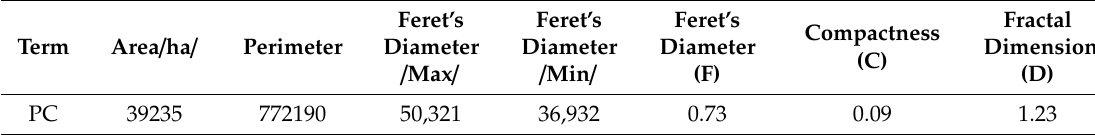
Table 6. Fractal dimension of the polycentric concept (PC).